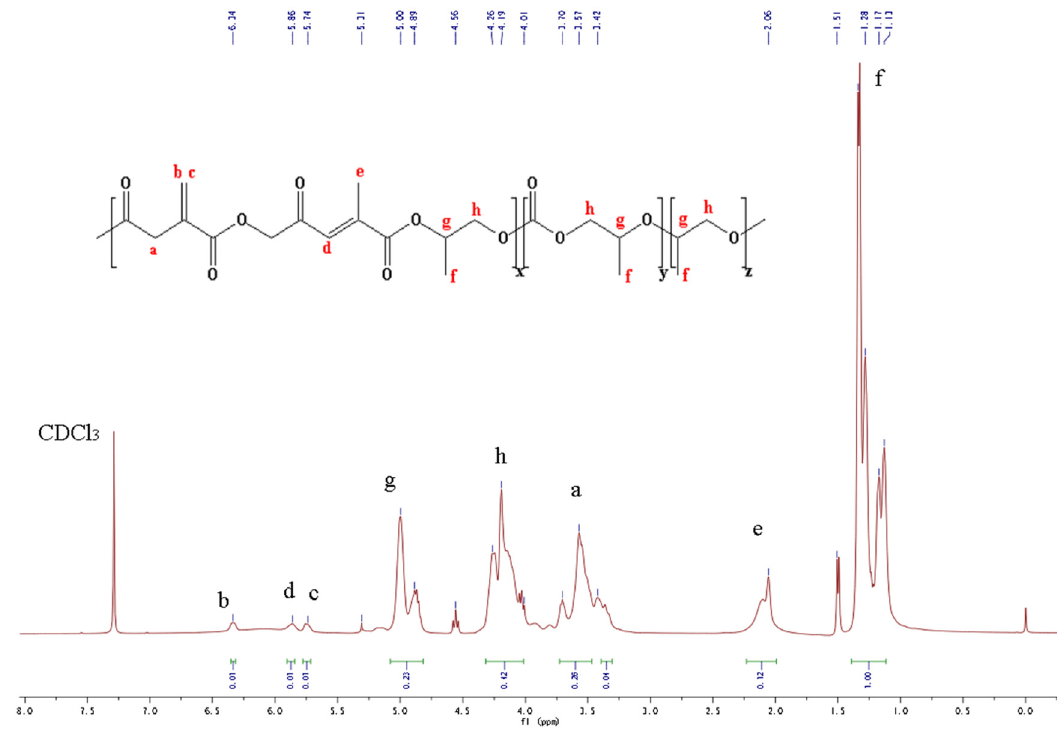
Figure A6: 1 H - NMR spectrum of copolymer PPCIAn.